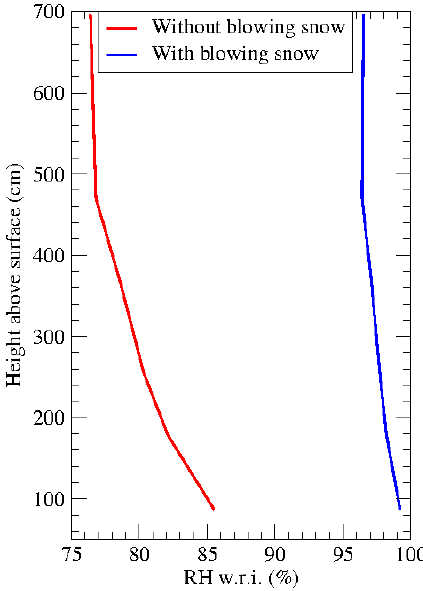
Figure 5. Profiles of mean 2011–2012 observed relative humidity with respect to ice, when blowing snow occurs to large (blue) and weak or null (red)